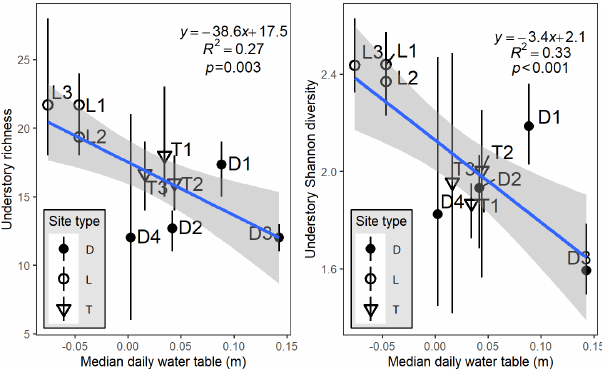
Figure 2. Plot-level richness or diversity, aggregated by site, as a function of the site-level median water table relative to the ground surface (negative values indicate belowground). Letters and sym- bols refer to hydrogeomorphic site types: D refers to depression sites, L refers to lowland sites, and T refers to transition sites. Ver- tical bars on points indicate bootstrapped 95% credible intervals calculated from the three plot measurements per site. The linear re- gression model results presented are also shown. Hydrology sum- maries are provided in Table